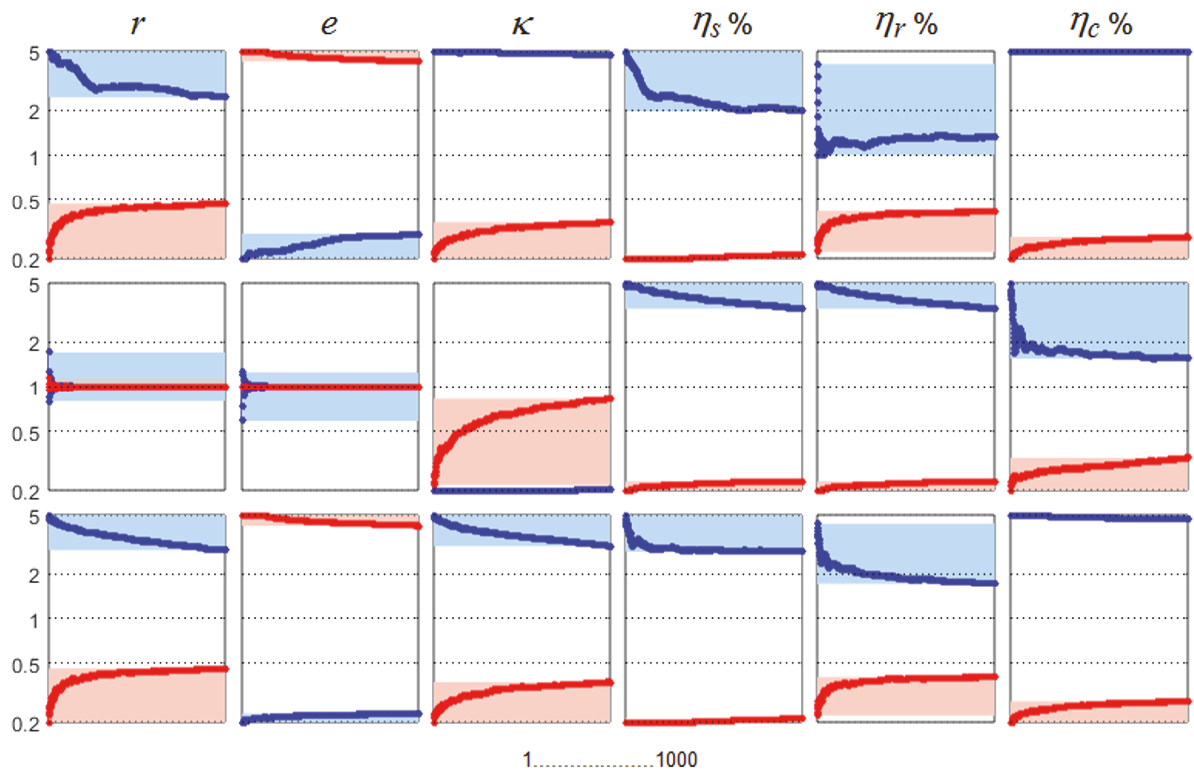
Figure6:Averagevaluesofsystemparametersproducinglowest(blue)andhighest(red)levelsofkineticenergy.Top:source;middle:receiver; bottom: entire system.